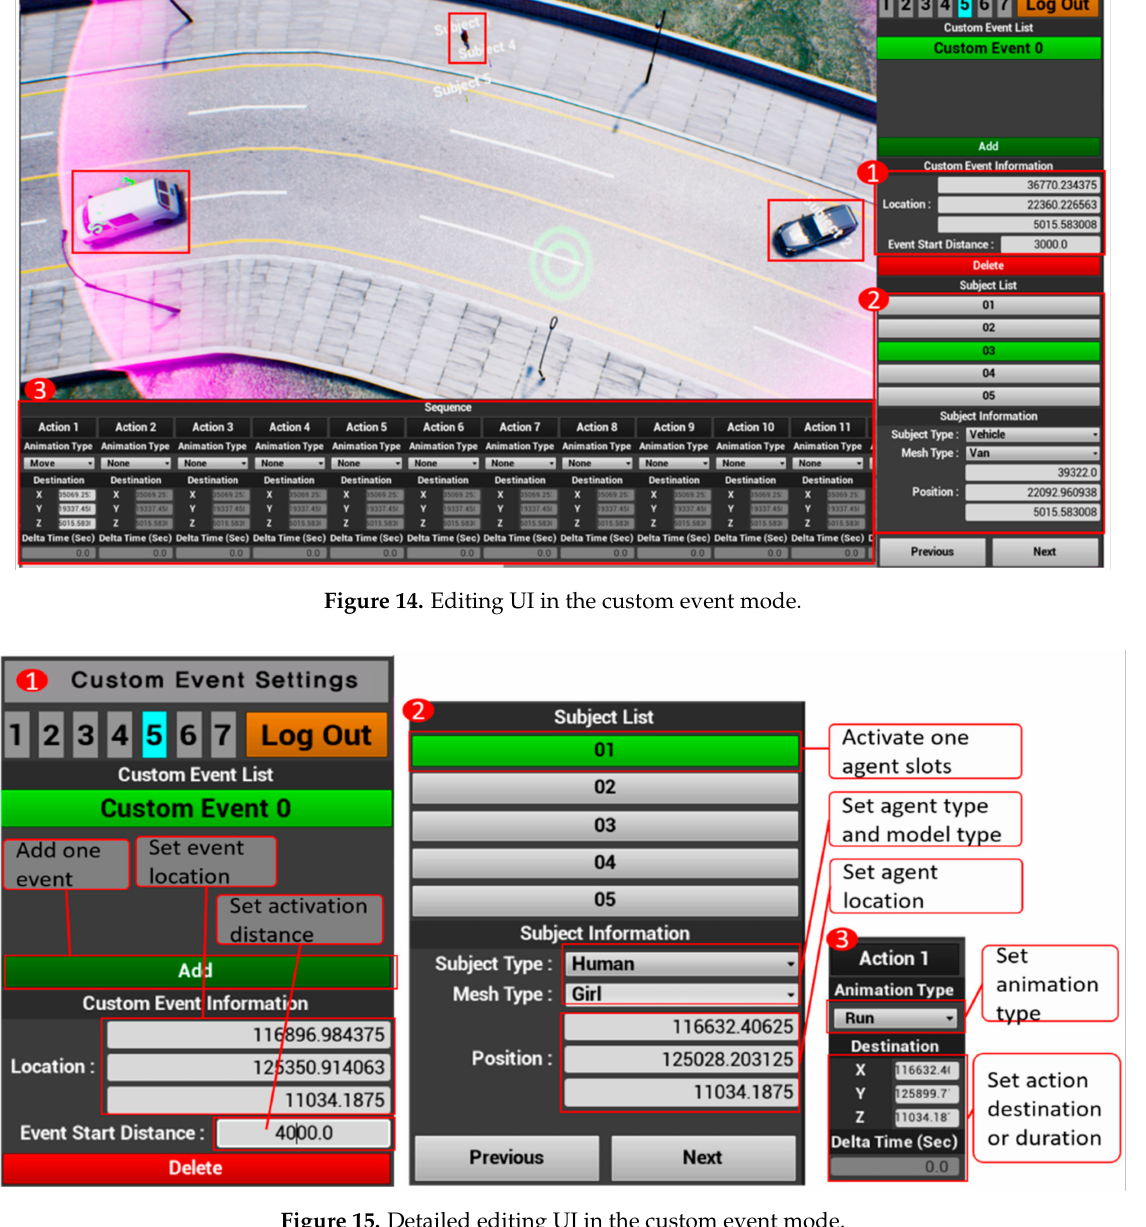
Figure 15. Detailed editing UI in the custom event